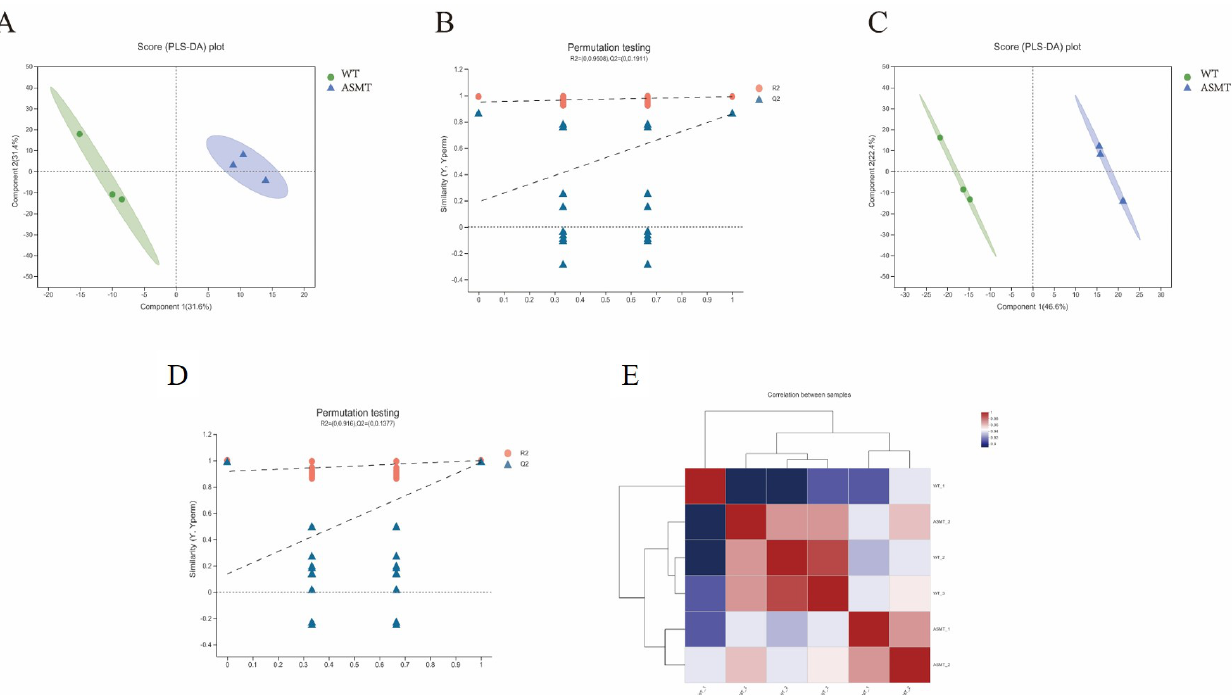
Figure 7. PLS-DA and heat map analyses in transgenic (ASMT) and WT goats. ( A ) Positive ion score (PLS-DA) chart; ( B ) positive ion array detection; ( C ) negative ion score (PLS-DA) chart; ( D ) anion array detection; ( E ) metabolite heat map analysis. Note: the transgenic goat ( n = 3), wild type ( n =